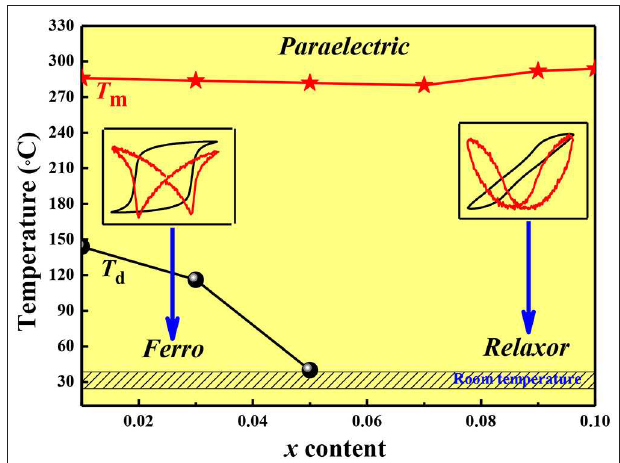
FIGURE 8 | Temperature-composition phase transition diagram of BNKT- x FSN